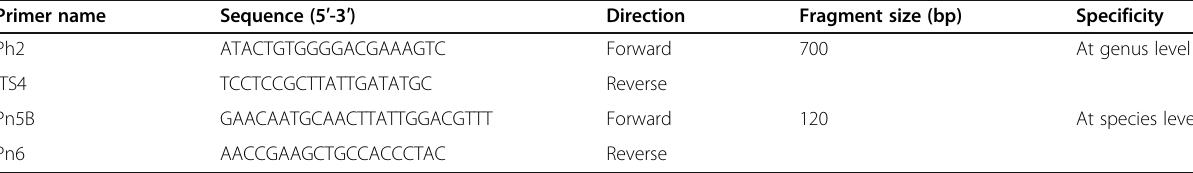
Table 2 Phytophthora genus and species specific primers sequence